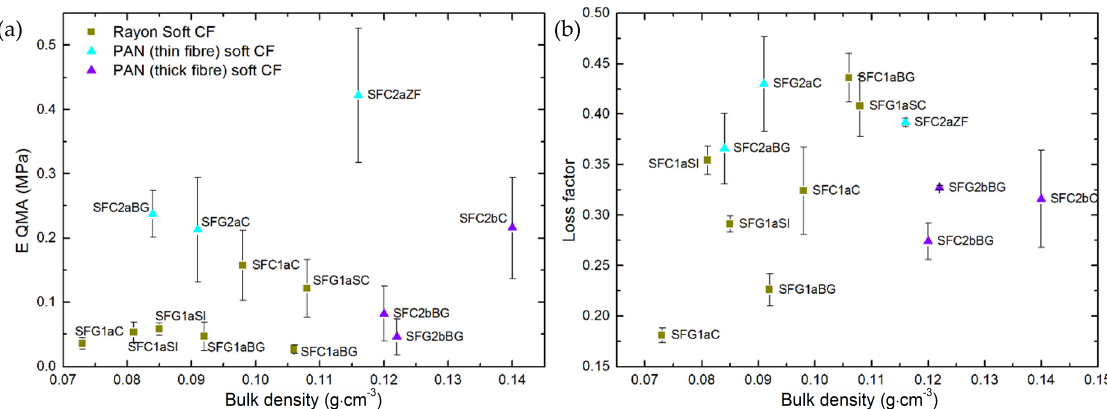
Figure 9. Elastic and damping parameters obtained by quasi-static mechanical analysis (QMA) as a function of bulk density: ( a ) Elastic modulus and ( b ) loss factor. The symbols have the same meaning as in Figure 5.